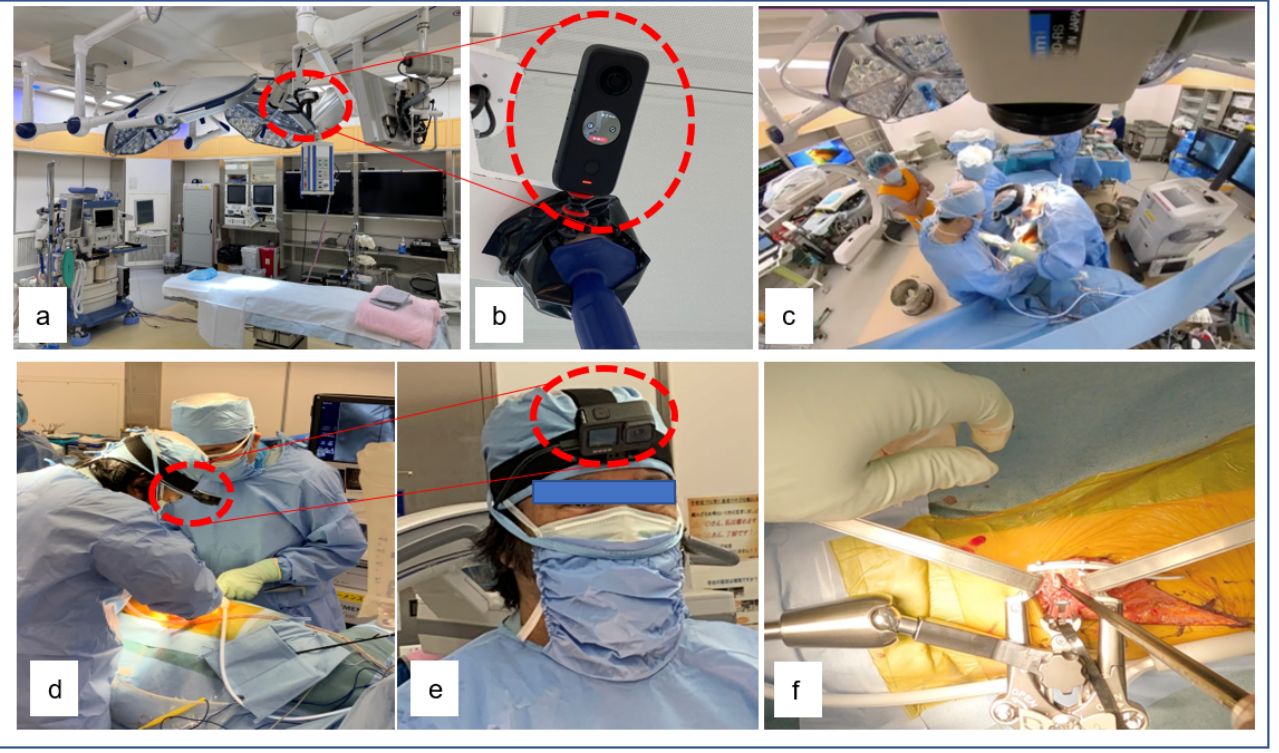
Figure 2. High ‐ resolution videos: 360° cameras ( a , b ) and surgical videos for spine surgery ( c ). A Figure 2. High-resolution videos: 360 ◦ cameras ( a , b ) and surgical videos for spine surgery ( c ). A video video is taken by the GoPro ( d , e ) from the surgeon’s point of view ( f ). is taken by the GoPro ( d , e ) from the surgeon’s point of view ( f